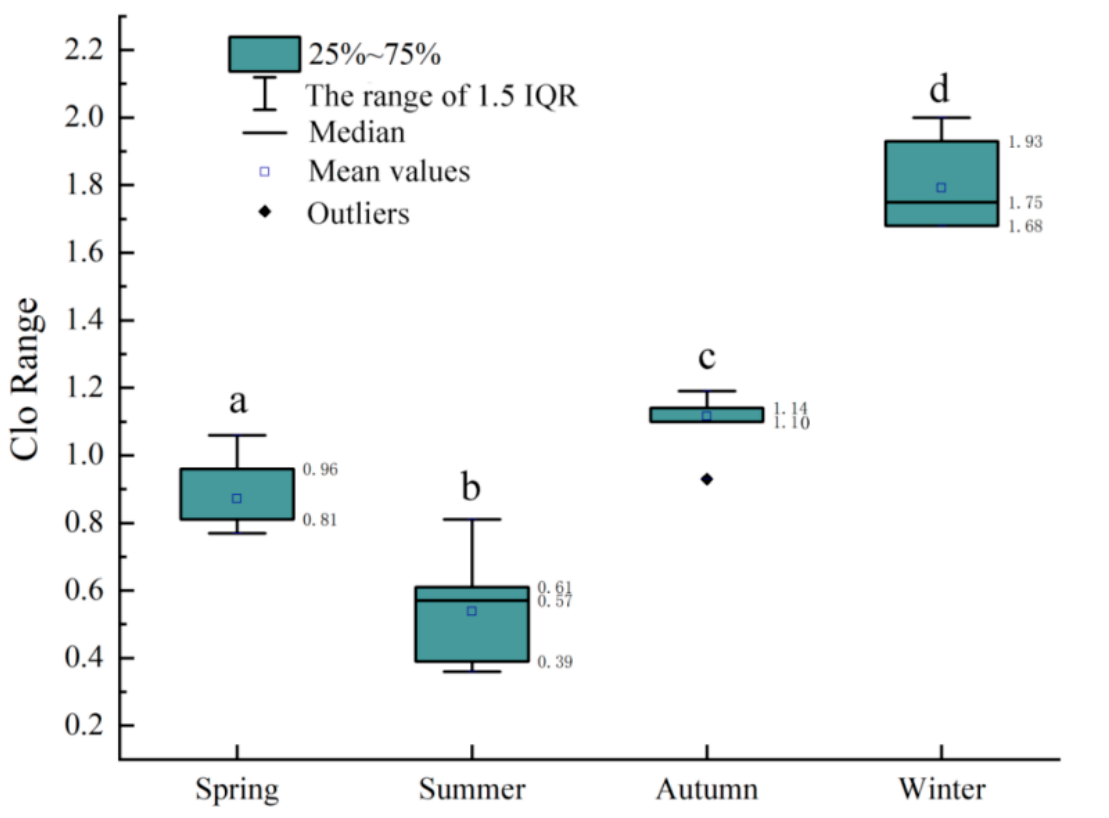
Figure 5. The seasonal Clo range of the elderly in nursing home. Note: Values followed by different letters (a, b, c, d) indicate there is statistically significant difference among the treatment groups at p ≤ 0.05 (5%) according to the multivariate general linear model followed by a Duncan’s post hoc test in SPSS. The common letters indicate there is no significant difference among groups.